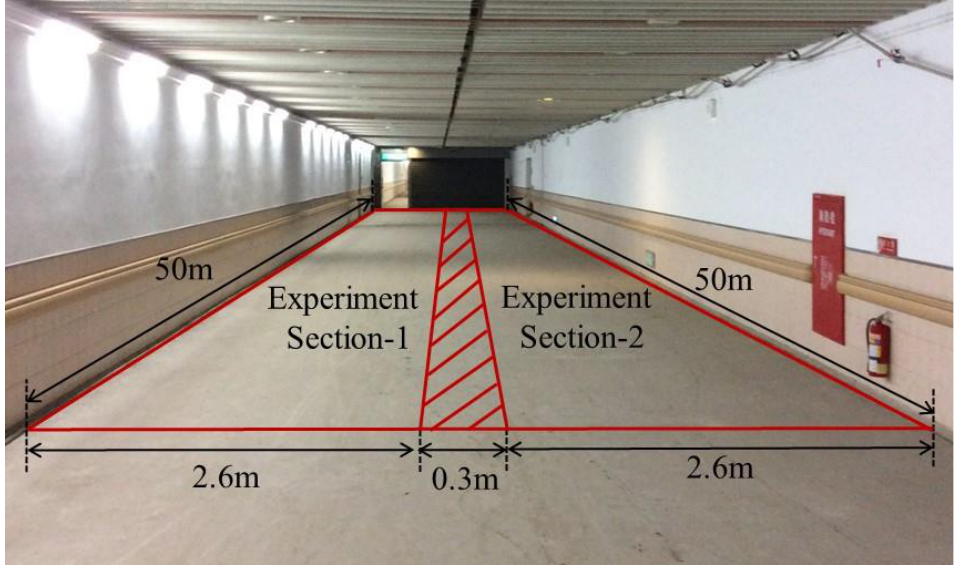
Figure 3. Evacuation experiment place.